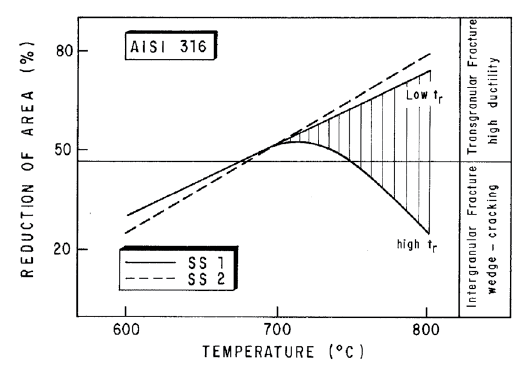
Figure 6. Schematic diagram displaying the creep fracture characteristics of the two investigated 316